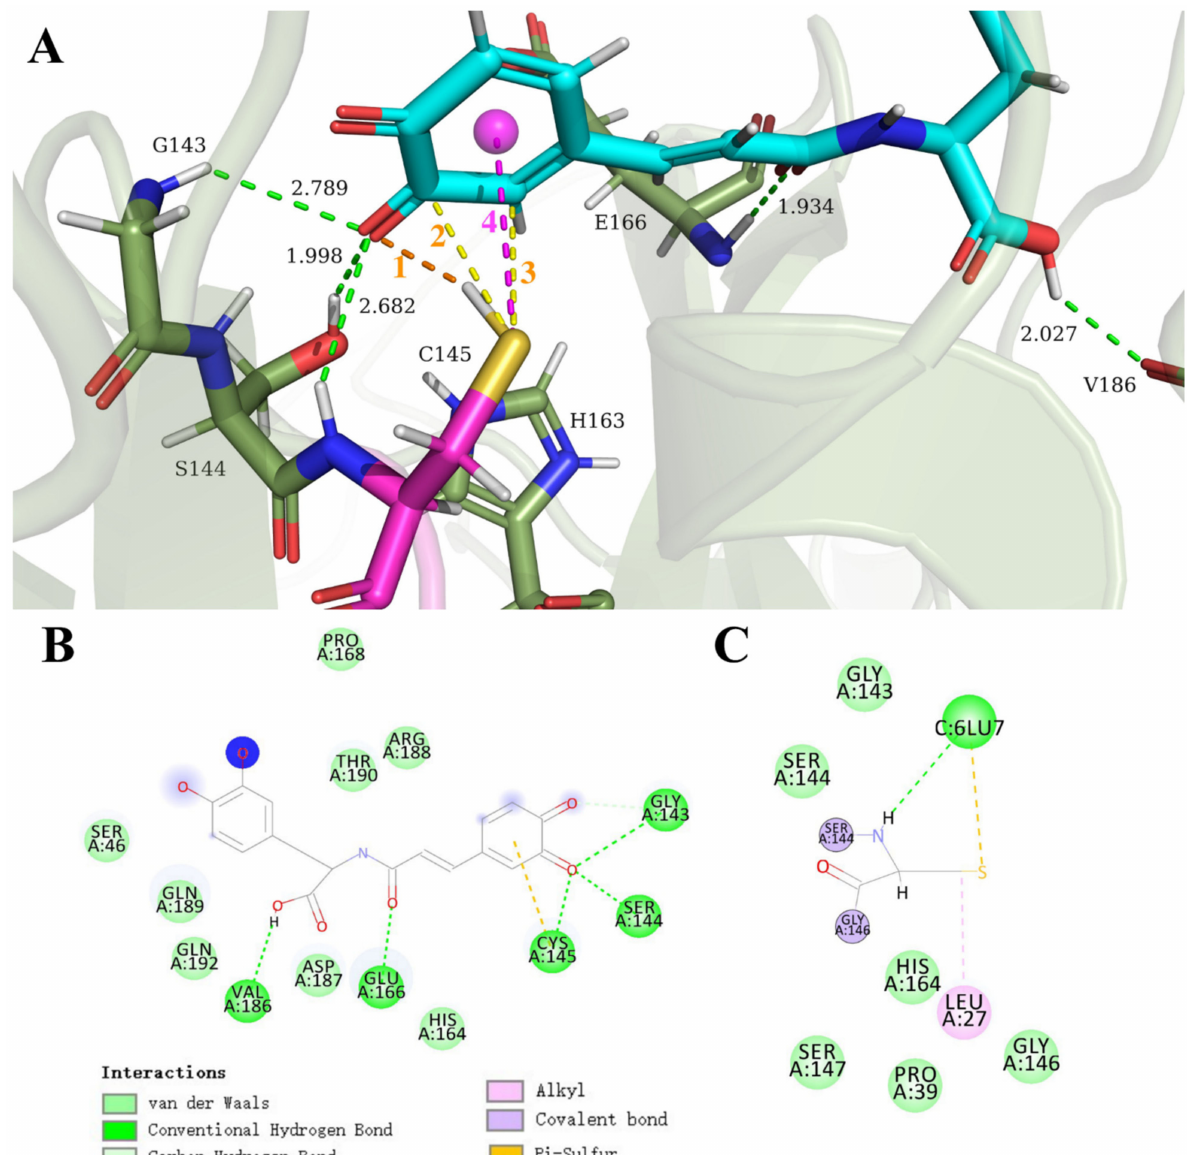
Figure 4. ( A ) Result of dynamic cascade of pose 1 of clovamide quinone derivative A displays the cysteine residue positioned in proximity to the quinone ring. The distances involved are labeled in numbers; 1 : H(C145) to O(C=O), 2.136 Å; 2 : S(C145) to C(C=O), 3.254 Å; 3 : S(C145) to the α carbon of the carbonyl group, 3.305 Å; 4 : (colored in magenta): S(C145) to quinone centroid, 3.450 Å. The first three distances are colored in yellow (hydrogen capture colored in orange) indicating their potentials in the inhibitory mechanism. ( B ) Two-dimensional display of non-covalent interactions of clovamide quinone derivative after dynamics cascade; ( C ) 2D display of interactions involved in C145